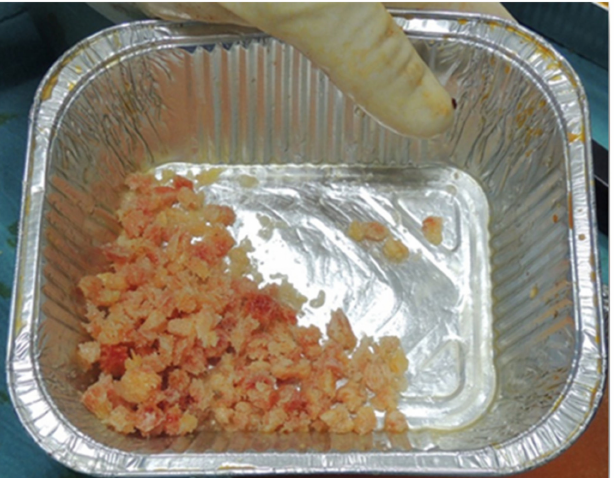
Figure 3. Bone chips after repeated washing to eliminate blood and bone marrow fat.